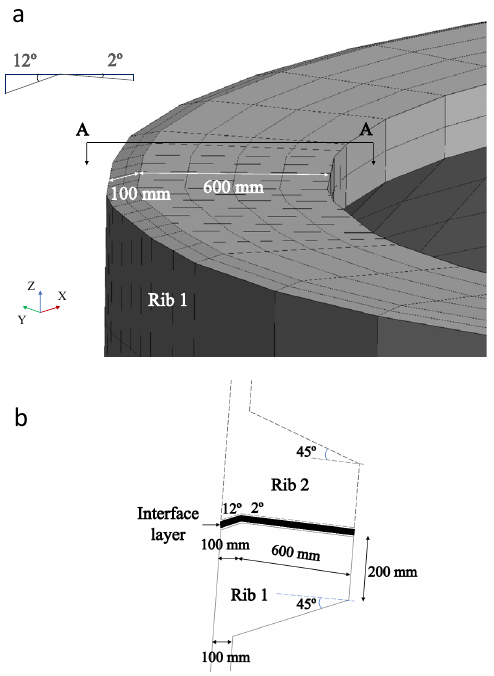
Figure 4. Geometry of the circumferential rib connecting two rings: (a) 3D and (b) 2D, cross section AA. Solid hexahedra FE of 8 nodes are used to simulate the SFRC, with 2  2  2 Gauss Legendre integration scheme. A maximum of 2 cracks is allowed to form at each integration point, with a threshold angle of 30 degrees for the new crack formation (2 nd crack). For assuring the results to be independent of the FE mesh refinement, a crack bandwidth equal to the cubic root of the volume of the integration point (IP), is